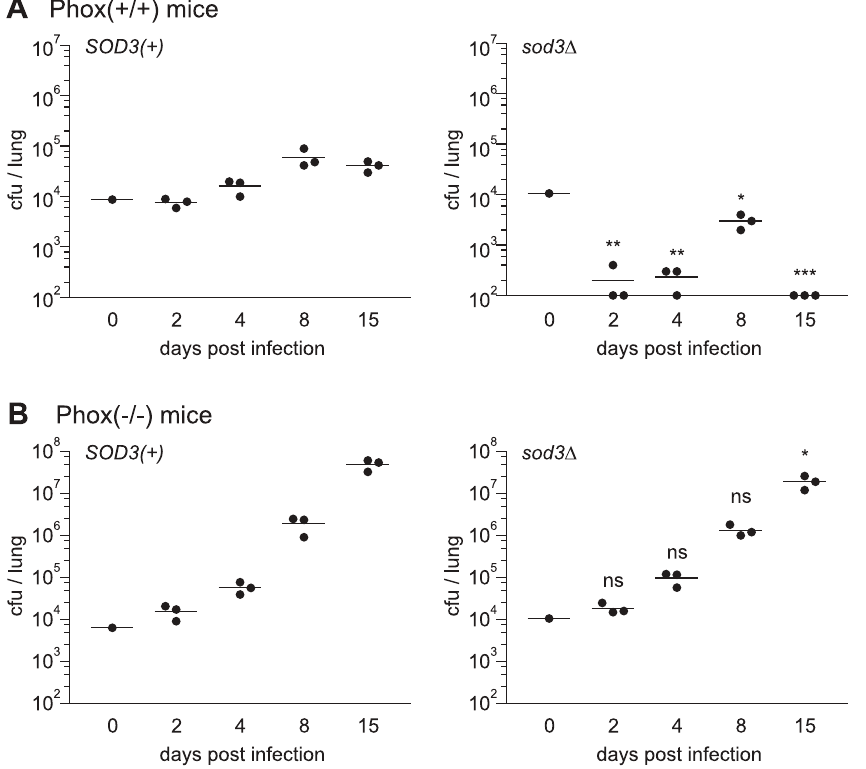
Figure 9. Sod3 facilitates infection through detoxification of host reactive oxygen. Kinetics of sublethal lung infection by Histoplasma in animals competent for ROS production ( A ) or animals lacking the NADPH-oxidase function ( B ). Mice were intranasally infected with approximately 1 6 10 4 SOD3( + ) (OSU45) or sod3 D (OSU15) Histoplasma yeasts. At 2, 4, 8, and 15 days post-infection, the fungal burden in lungs was determined by quantitative platings for Histoplasma cfu. ( A ) Respiratory infection of Phox( + / + ) mice isogenic to the p47 phox knock-outs. ( B ) Respiratory infection of p47 phox knock-out (Phox( 2 / 2 )) mice. Each data point represents cfu counts per lung from an individual animal (n=3 per time point) and horizontal bars represent the mean fungal burden. Non-significant (ns) or significant differences (* p , 0.05, ** p , 0.01) from animals infected with SOD3( + ) organisms is indicated above the respective columns. The actual inoculum dose is shown in graphs at day 0. The limit of detection is 100 cfu.